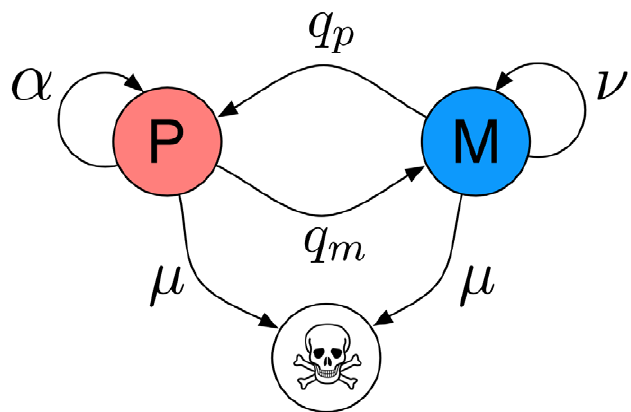
Figure 1. Schematic describing the continuous time Markov process each cell is subject to. A living glioma cell can be in either of two states, proliferating (P) or migrating (M), and transitions between the states with rates q p and q m respectively. A P-cell divides at rate a while an M-cell moves with rate n . Both cell types go into apoptosis and die with a constant rate m .